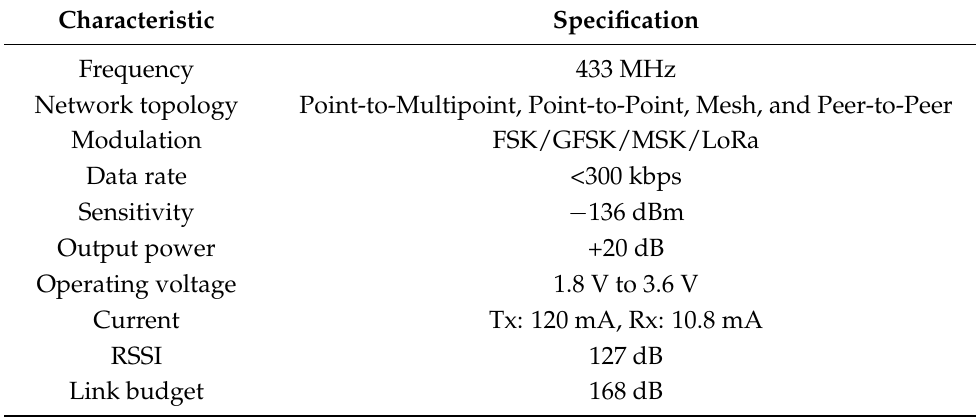
Table 1. SX 1278 LoRa specifications [35].